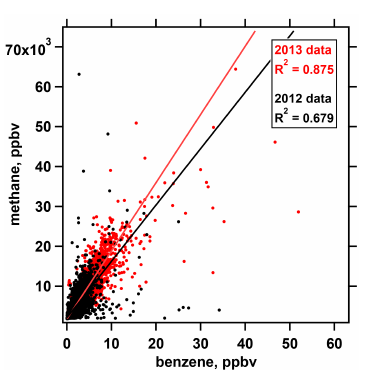
Figure 5. Correlation between methane and benzene for all data taken in 2013 (red) and 2012 (black).